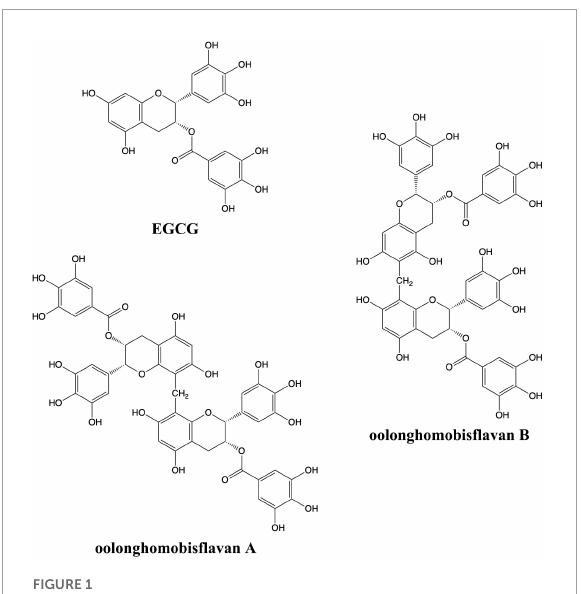
FIGURE1 Chemical structures of EGCG, OFA, and